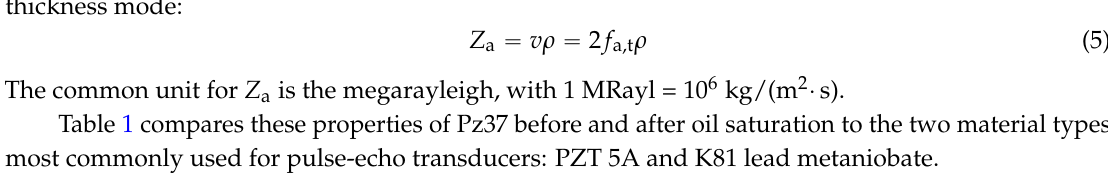
Table 1. Properties of Pz37 piezoceramic discs measured before and after oil impregnation. For all values stated, the relative standard deviation was less than 1.5%, except for Q m for which it varied between 2.3% and 6.1%. Typical values for PZT 5A (commercial soft-doped PZT) and K81 (modified lead metaniobate from Meggitt Indiana) are given for